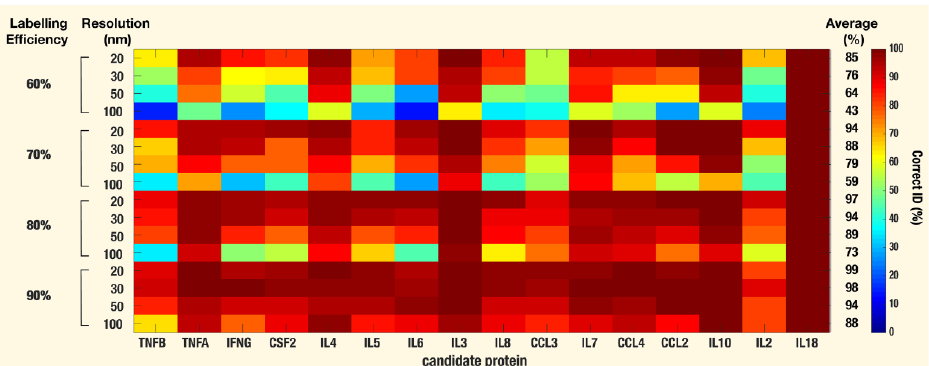
Fig. 3 Colour moment distribution diagram of a single piece of degraded/standard